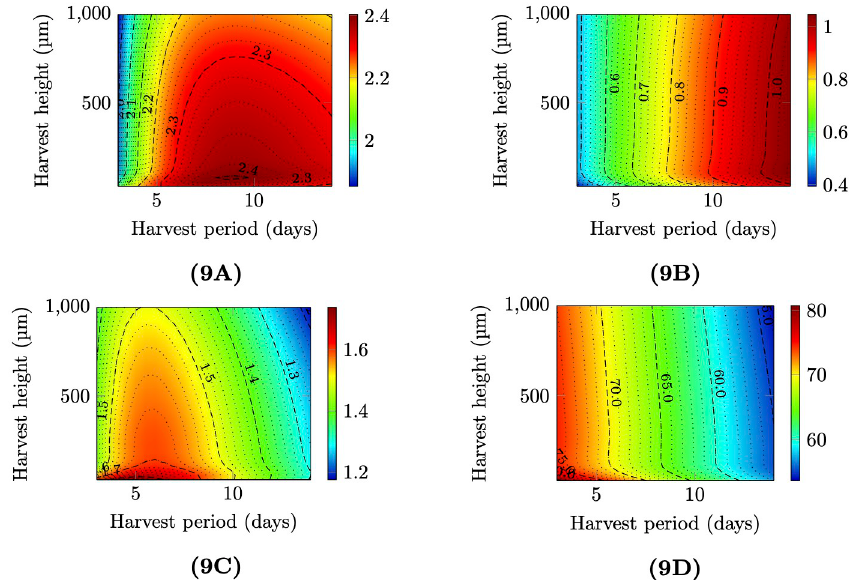
Fig 9. Daily production rates obtained using 1D numerical simulation (ie. uniform scraping pattern) for different biofilm components and biofilm compositions with respect to harvest period and height. Fig 9A: Daily production rate of dry biofilm ( A + N + E ). Fig 9B: Daily production rate of dry ECM ( E ). Fig 9C: Daily production rate of dry microalgae ( A + N ). Fig 9D: Biofilm composition: dry biomass percentage within microalgae ( A + N )/( A + N + E